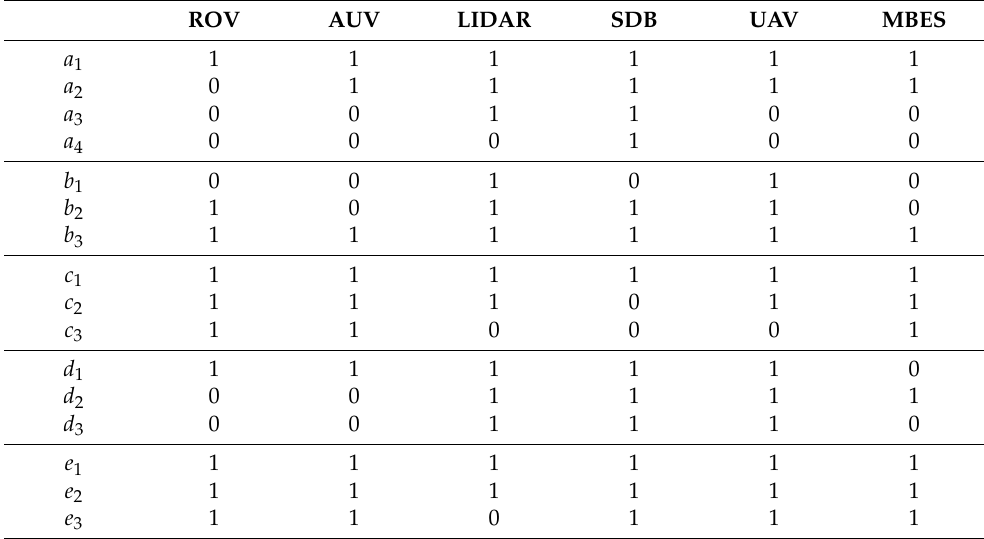
Table 4. Reduced binary elimination matrix for the study case.